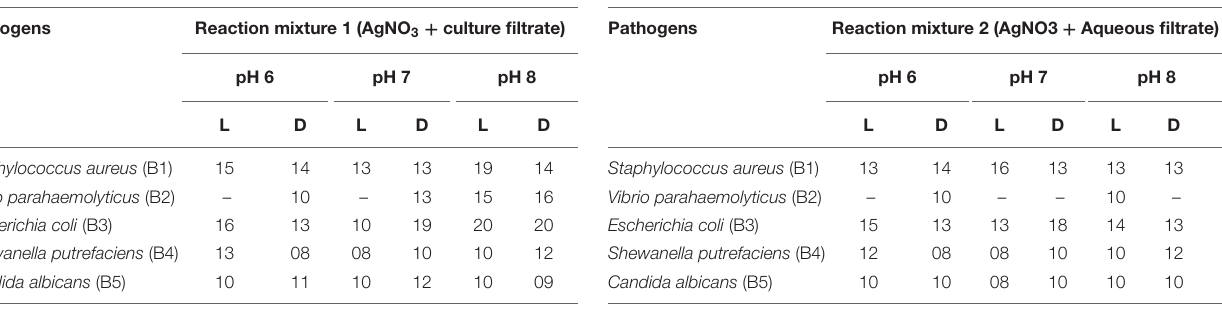
TABLE 3B | Antimicrobial activity of aqueous filtrate and different light condition-mediated biosynthesized